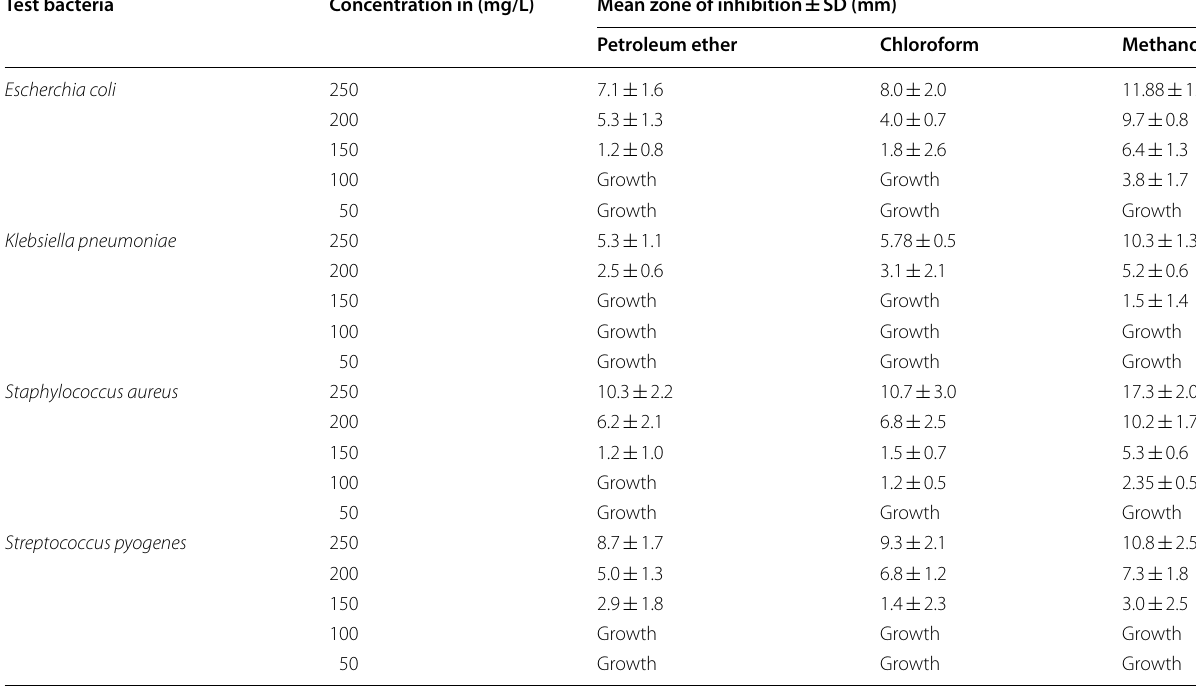
Values are expressed in mean SD of three individual experiments ± The word “growth” represents zero inhibition zone the extract at a given concentration